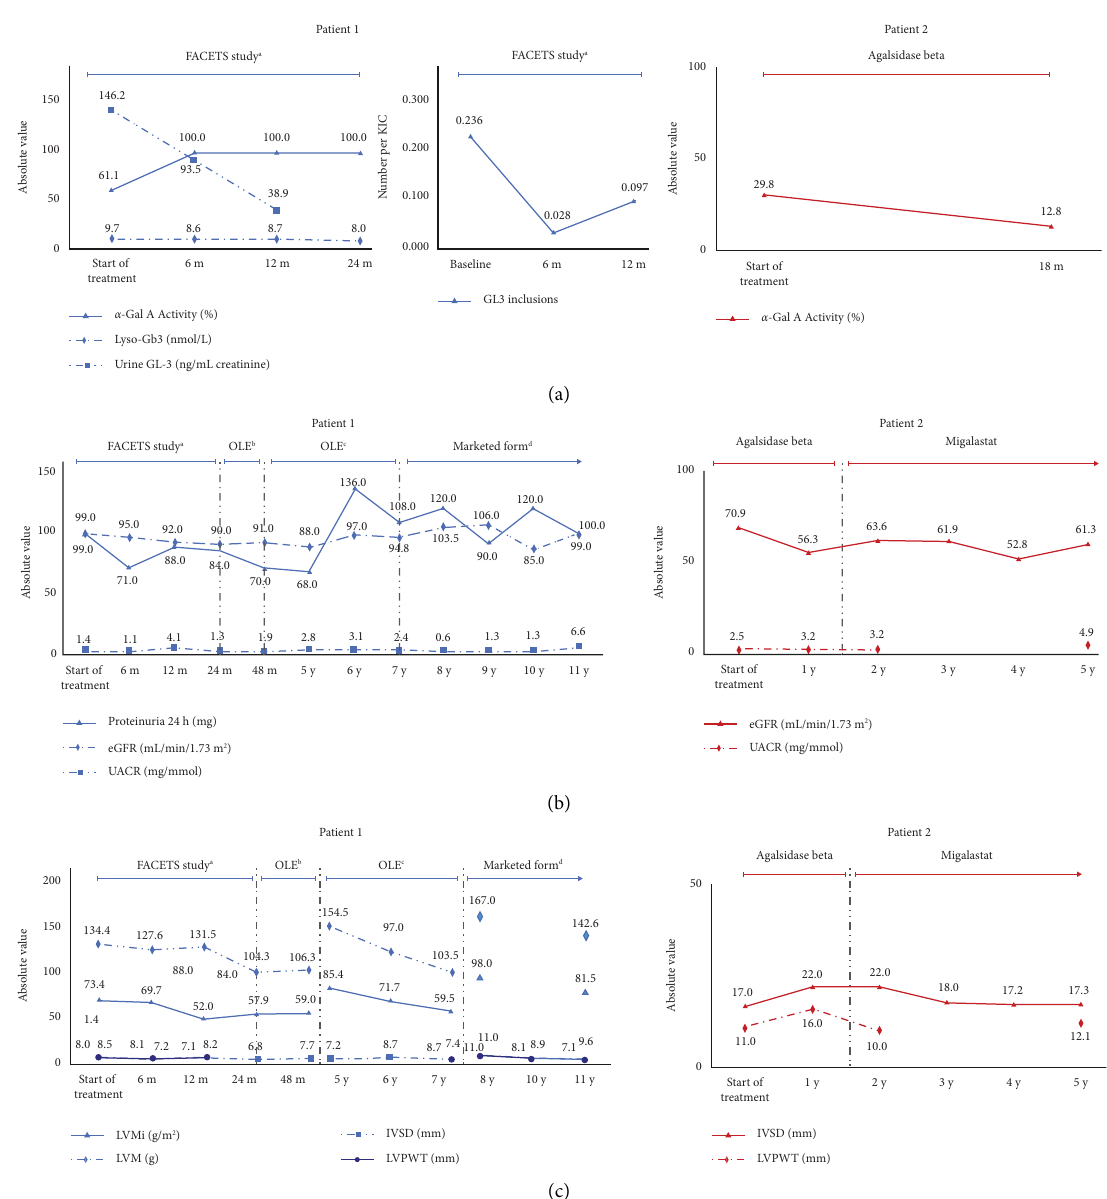
Figure 4: Changes in (a) Metabolism. (b) Renal. (c) Cardiac Parameters with treatment at diferent stages in two cases of FD. α -Gal A is expressed as a percentage of normal (% normal). Normal white blood cell activity: 22nmol free 4MU released/mg protein/h 7 (patient 1); normal laboratory reference activity on dried blood spots samples: 4.7–18.8 μ mol/L/h (patient 2); normal Lyso-Gb3: ≤ 0.6nm/L; normal urine GL-3: < 33.8ng/mL; normal protein excretion rate: < 150mg/24 hours; normal eGFR: > 90mL/min/1.73m 2 ; normal UACR: < 3mg/ mmol; normal LVMI: 43–95g/m 2 ; normal LVPWT: 6–10mm; normal IVSD: 6–9mm. Dotted lines defne the end of study (case 1) or treatment switch (case 2). In the cardiac parameters graph of case 1, gaps indicate a diferent method of measurement. Case 1: urine GL-3 and GL-3 inclusions were measured up to month 12 of the FACETS study; LVMI and LVM not measured at 8, 9, and 10 months; LVPWT measured upto 12 months of the FACETS study; case 2: UACR and LVPWTnot measured at years 3 and 4. a NCT00925301, b AT1001-041; c AT1001-042. α -Gal A, alpha-galactosidase A; eGFR, estimated glomerular fltration rate; FD, Fabry disease; GL-3, globotriaosylceramide; IVSD, interventricular septal thickness at end diastole; LVMI, left ventricular mass index; LVPWT, left ventricular posterior wall thickness; Lyso-Gb3, globotriaosylsphingosine; OLE, open-label extension; UACR, urine albumin-to-creatinine